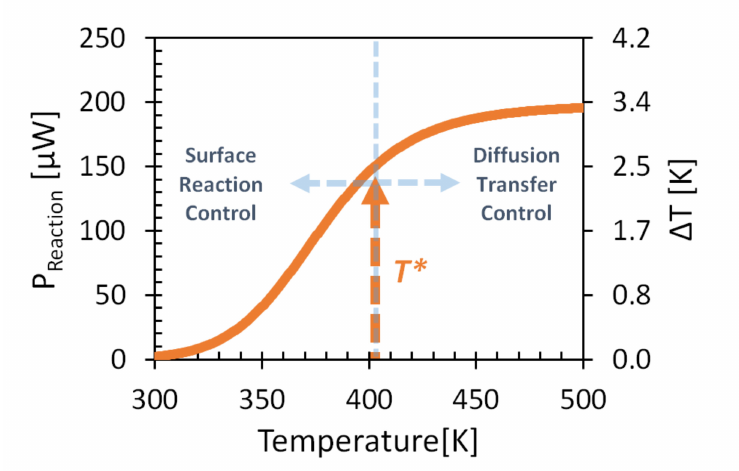
Figure 6. Calculated chemical-oxidation reaction power release due to 100 ppm combustion of ethanol on Pt catalyst as function of heated-pixel temperature. Average G TH = 60 µ W / K, D / δ = 1 m / s [22], E A ≈ 55.23 kJ / mole, and Z ≈ 10 7.66 m / s [32] were